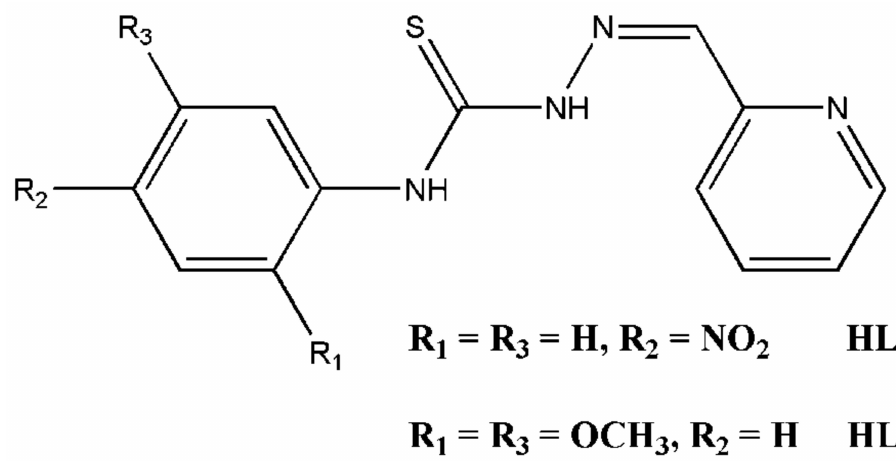
Figure 1. Structures of the TSC ligands.